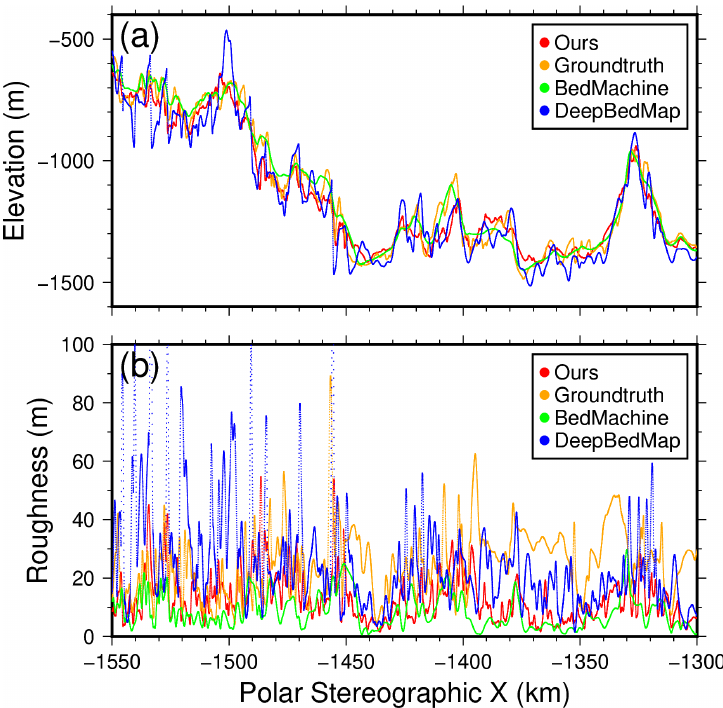
Figure 10. Comparison bed elevation ( a ) and bed roughness ( b ) of each grid product over a transect (see Figure 9, orange